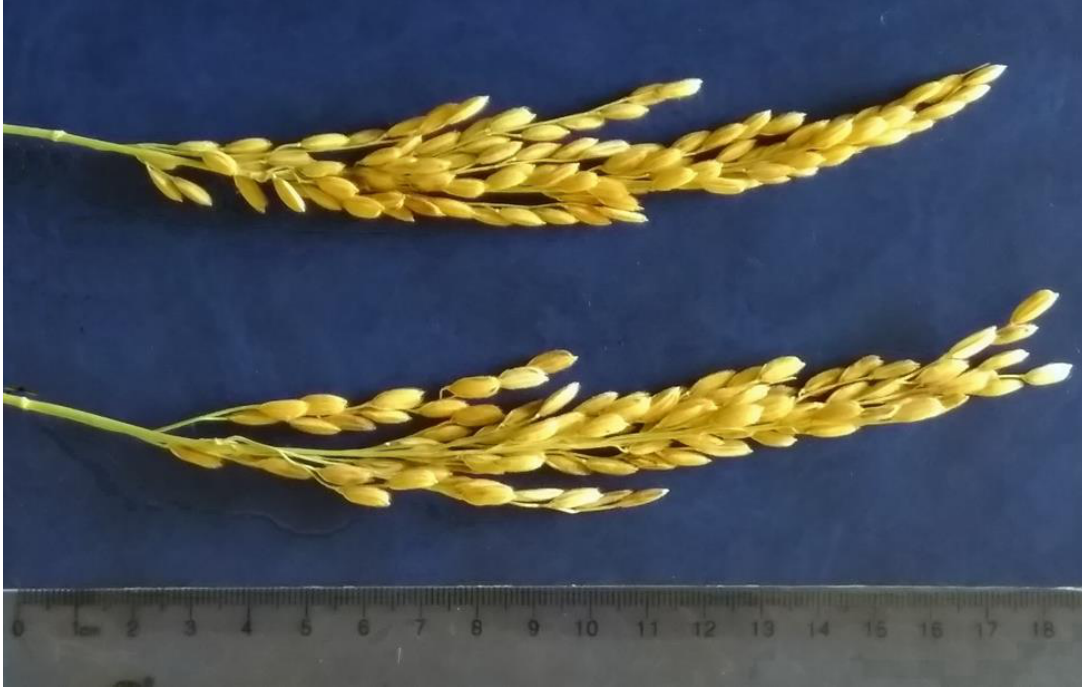
Figure 5. Rice panicles of the variety Kapitan.